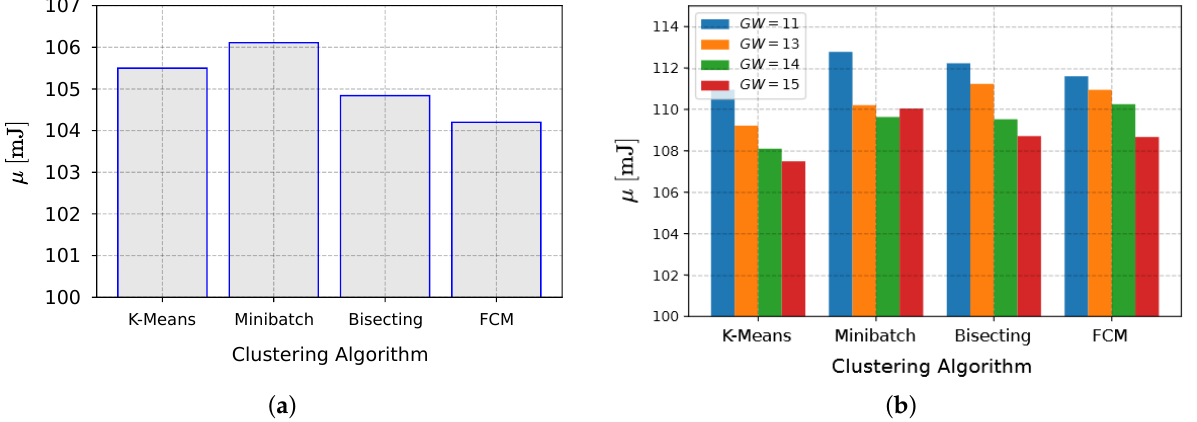
Figure 12. Mean energy consumption for the best p -value situation considering ( a ) Scenario 1 (two GWs), and ( b ) Scenario 2 (GW